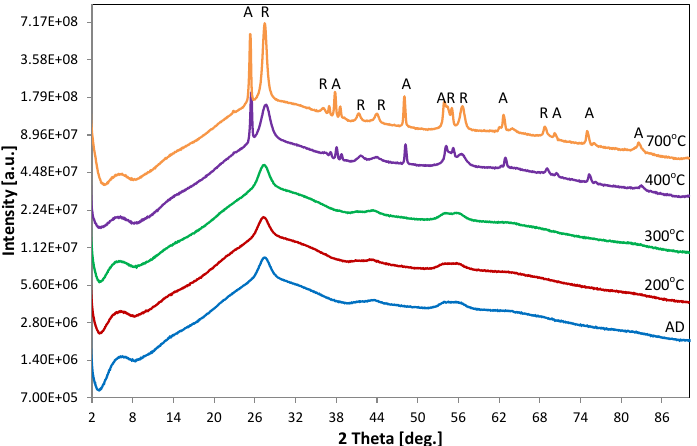
Figure 6. XRD diffractograms collected from TiO 300, 400 and 700 °C for 10 min. Lines represent peak position for anatase (red) and rutile (black) phases,